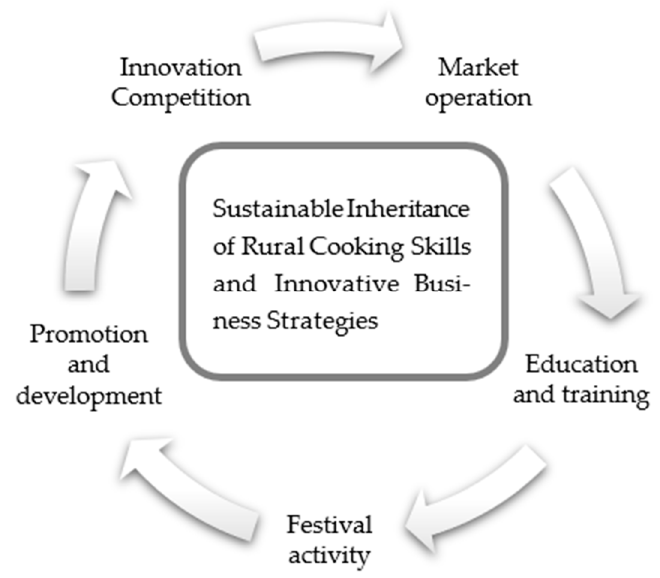
Figure 1. Research framework.